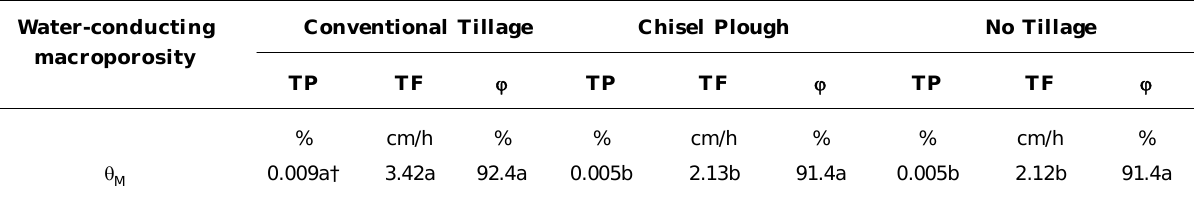
† Different letters indicate statistically significant differences between treatments (LSD test;